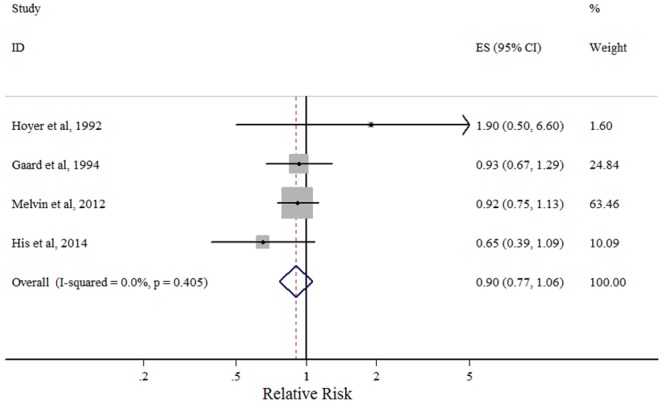
Forest plot of the highest vs. lowest categories of serum LDL-C levels and breast cancer risk.Squares indicate study-specific relative risk estimates (size of the square reflects the study-specific statistical weight); horizontal lines indicate 95% confidence intervals (CI); diamond indicates the overall relative risk with its 95% confidence interval.